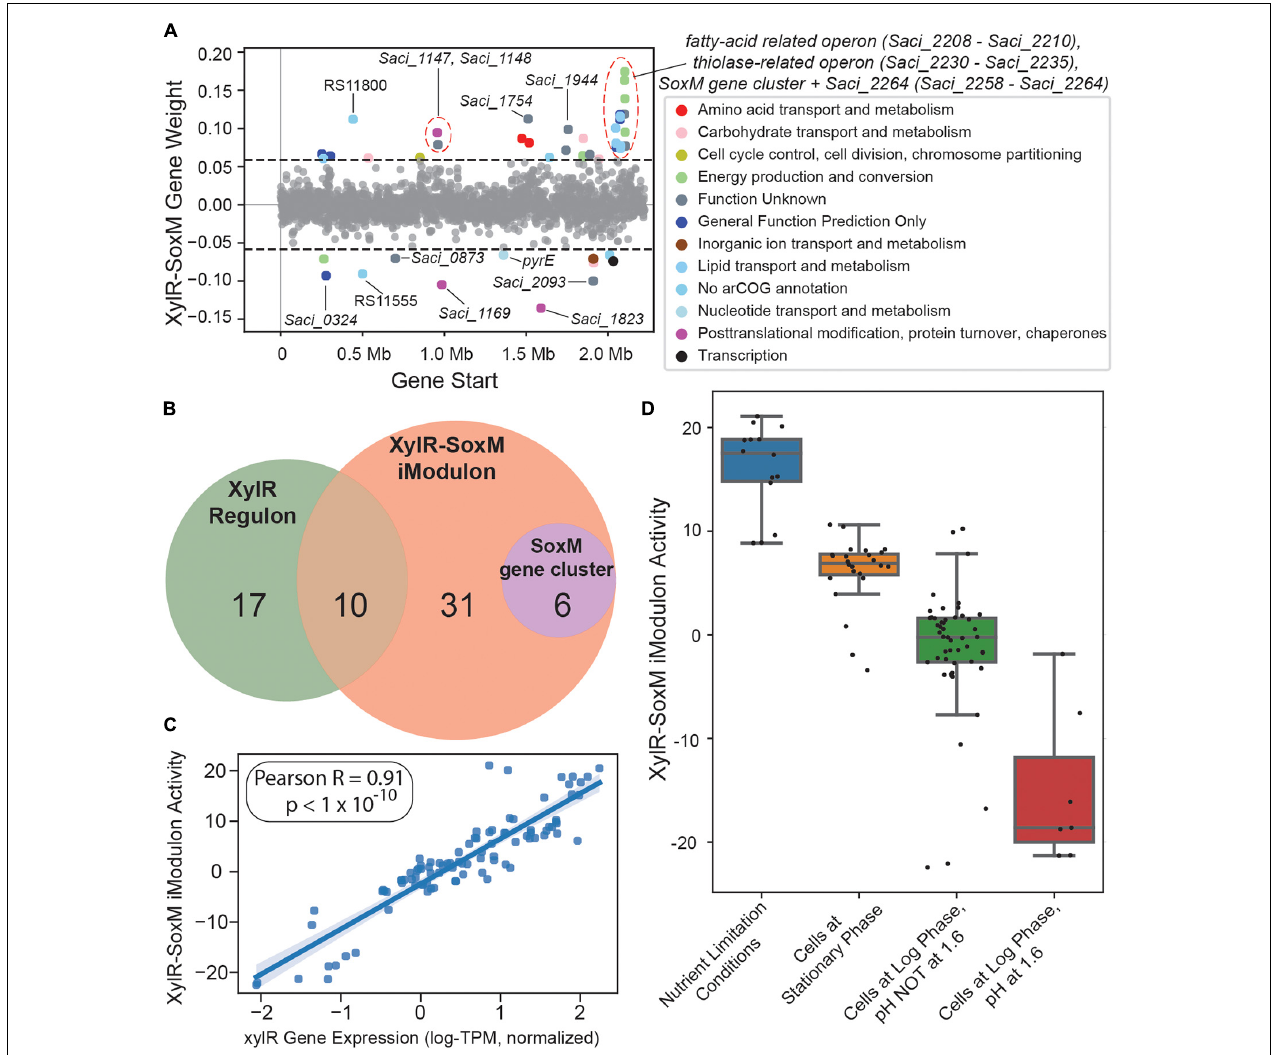
FIGURE 6 | Overview of the XylR-SoxM iModulon. (A) Scatter plot of the gene weightings for this iModulon. Genes are colored by COG categories. (B) Venn diagram comparing the XylR regulon, XylR-SoxM iModulon, and the SoxM gene cluster. (C) Scatterplot of xylR gene expression ( X -axis) vs. XylR-SoxM iModulon activity ( Y -axis). The correlation coefficient for this data is 0.91. (D) Boxplot of XylR-SoxM activities by condition. “Nutrient Limitation Conditions” refers to all samples in the RNA-seq compendium which were exposed to any nutrient-limitation